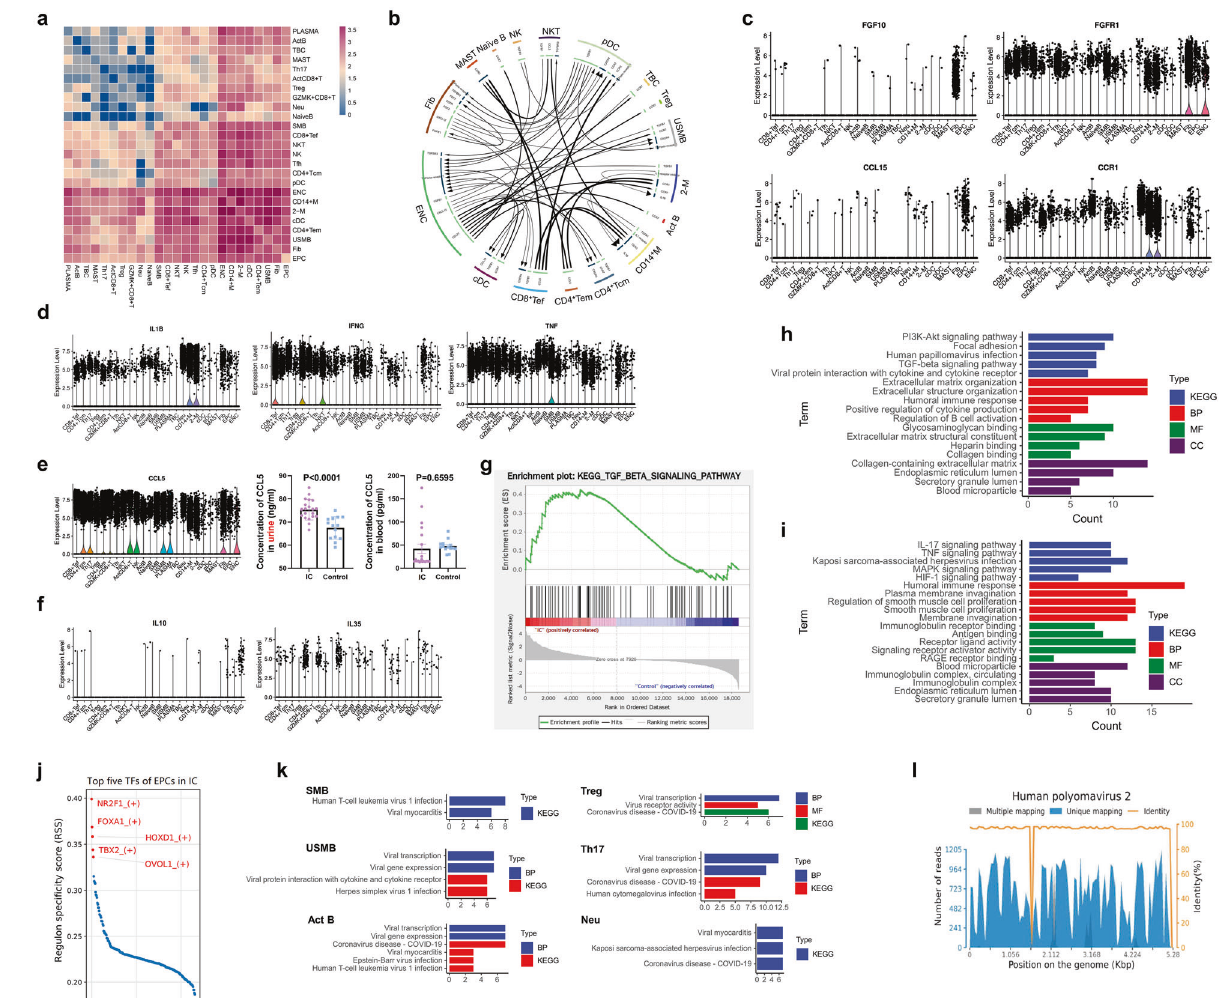
Fig. 5 Cellphone DB analysis based on scRNA-seq showed the crosstalk in the immune network. a Heatmap showing the distribution of interaction pairs across the cell types. b Cell – cell communication network in IC based on the top 50 interaction pairs. c Violin plot showing the expression of interaction pairs including CCL15-CCR1 on epithelial cells and FGF10-FCGR1 on fi broblasts. d The expression of in fl ammatory genes including TNF, IL-1 β , and IFNG across the clusters. e Violin plot showed the upregulated expression of CCL5 across immune cells, which was validated by Enzyme-linked-immunosorbent serologic assay tests in urine ( P < 0.0001), but not in blood ( P = 0.6595) (Mann – Whitney U -test, two-tailed; IC, n = 20; control, n = 14). f The downregulated expression level of IL-10 and IL-35 across immune cells. g The differentially expressed genes (DEGs) in Tregs in the IC group compared with the control group were enriched and upregulated in TGF- β signaling pathway. h Enrichment analysis of DEGs of epithelial cells. i Enrichment analysis of DEGs of fi broblasts. j Top 5 transcription factors of epithelial cells. k Bar plot showing the virus-related enriched results in selected cell types. l Human po l yomavirus-2 was detected in IC urine with 95% positive rates, but 0% in control urine (IC, n = 20; control, n = 14). IC interstitial cystitis, CD8 + Tef CD8 + effector T cell, CD4 + Tcm central memory CD4 + T cell, Treg regulatory T cell, CD4 + Tem effector memory CD4 + T cell, Tfh follicular helper T cell, Act CD8 + T activated CD8 + T cell, NK CD56 bright CD16 low natural killer cell, Act B activated B cell, SMB switched memory B cell, USMB un-switched memory B, PLASMA plasma cell, TBC transitional B cell, Neu neutrophil, CD14 + M in fl ammatory CD14 + macrophage, 2-M M2-like macrophage, cDC conventional dendritic cell, pDC plasmacytoid dendritic cell, MAST mast cell, Fib fi broblast, EPC epithelial cell, ENC endothelial